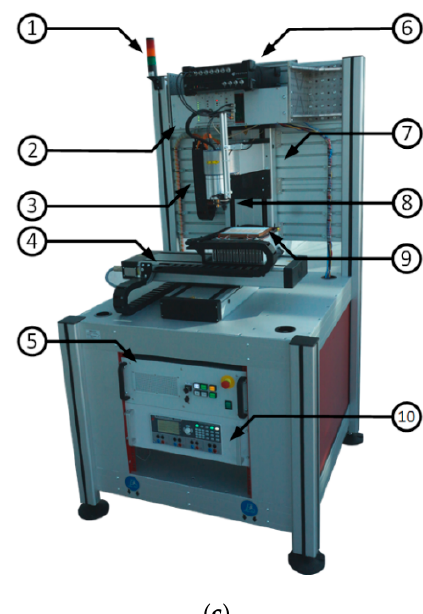
8 of 20 Figure 4. Evaluation methods in TTA: ( a ) Z th evaluation and ( b ) normalized logarithmic derivative. Data are generated by an optimized FEM model in a transient thermal simulation with a crack growth of 10% or 30% in the solder joint compared to its area described in [44]. An increase of 0.63 K/W or2.37 K/W was observed in Z th (t) and 0.012 or 0.044 in peak increase for B(z). In addition to the normalized logarithmic derivative, the structure function is a common evaluation method for TTA data. A detailed explanation would be beyond the scope of this paper and can be found in [46–48]. Independent of the chosen type of evaluation, the signal-to-noise ratio (SNR) is always a critical parameter for TTA [11]. A simple but time-intensive way to increase SNR is averaging over several measurement repetitions. In that way, a measurement of a single semiconductor can last from several seconds up to minutes depending on time required for the set-up to reach thermal equilibrium and the repetition count. An in-line implementation is, therefore, not feasible, and high-volume studies